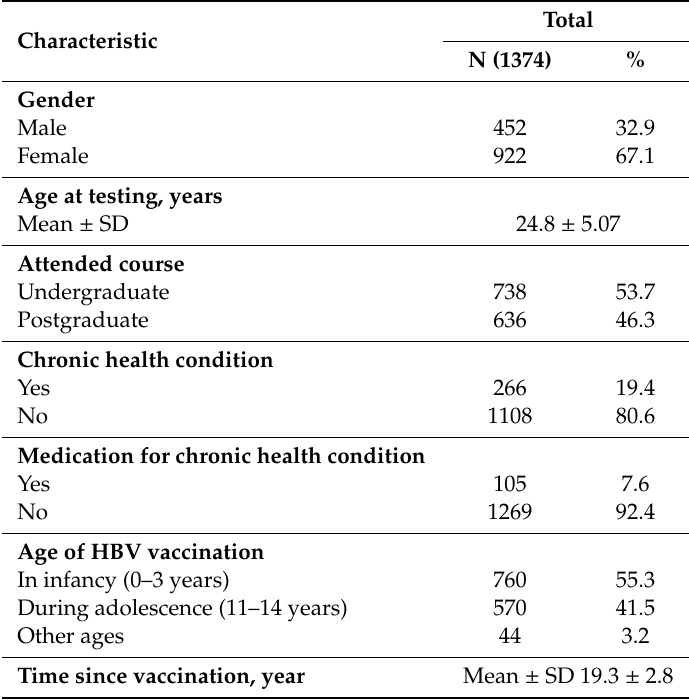
Table 1. Demographic and HBV vaccination characteristics of the study